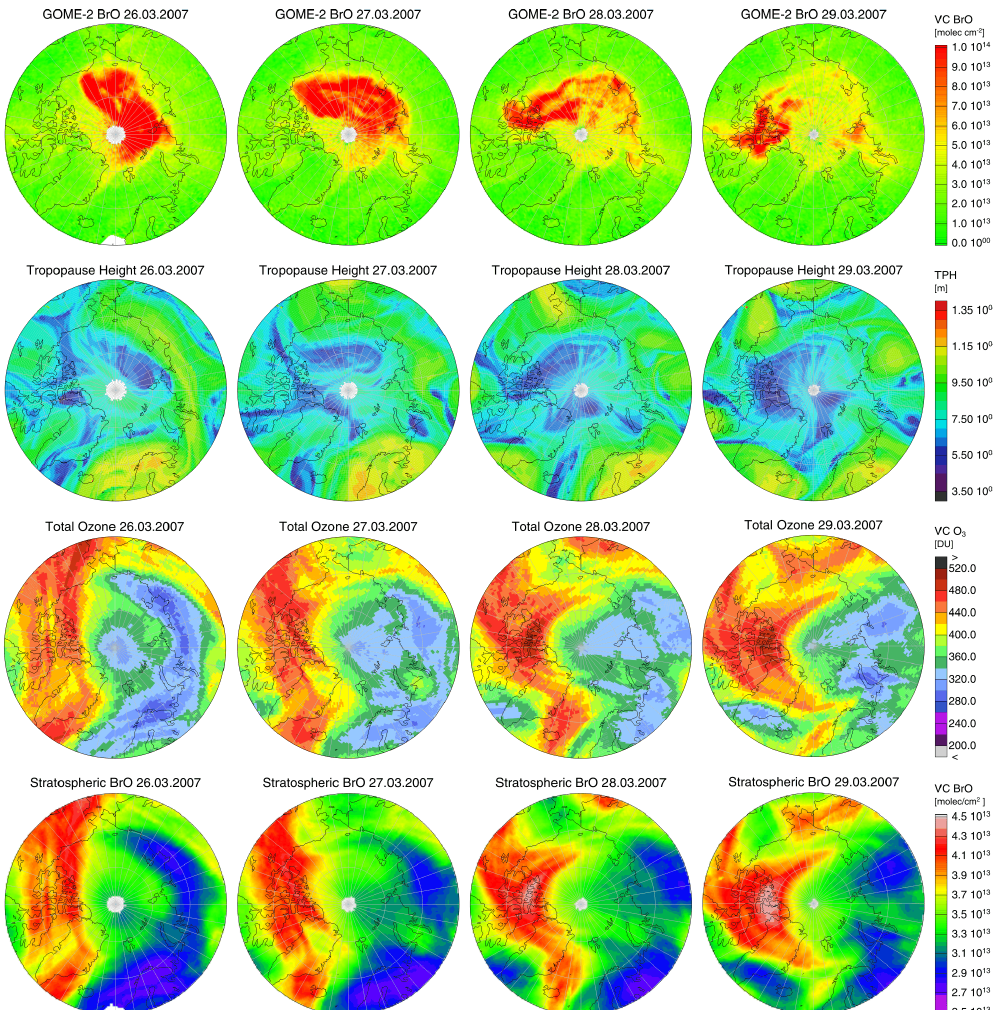
Fig. 7. Stratosphere corrected GOME-2 BrO (AMF 2000m) in comparison to Total Ozone(GOME-2), Tropopause Height (ECMWF data adjusted to GOME-2 orbits-courtesey of Andreas D¨ornbrack, DLR) and stratosperic BrO climatology data.